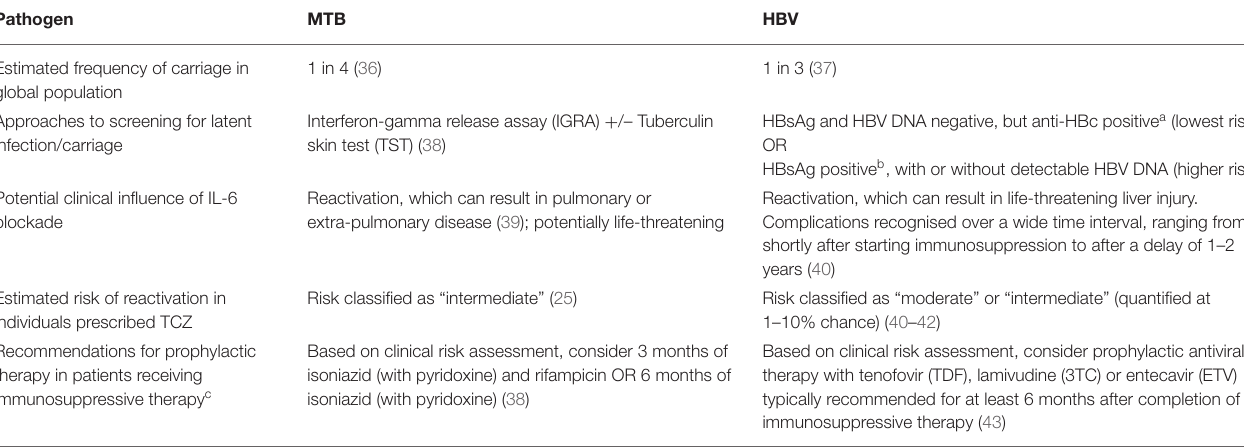
TABLE 1 | Features of Mycobacterium tuberculosis (MTB) and Hepatitis B Virus (HBV) infection pertinent to the use of therapeutic IL-6 blockade. Pathogen MTB HBV Estimated frequency of carriage in global